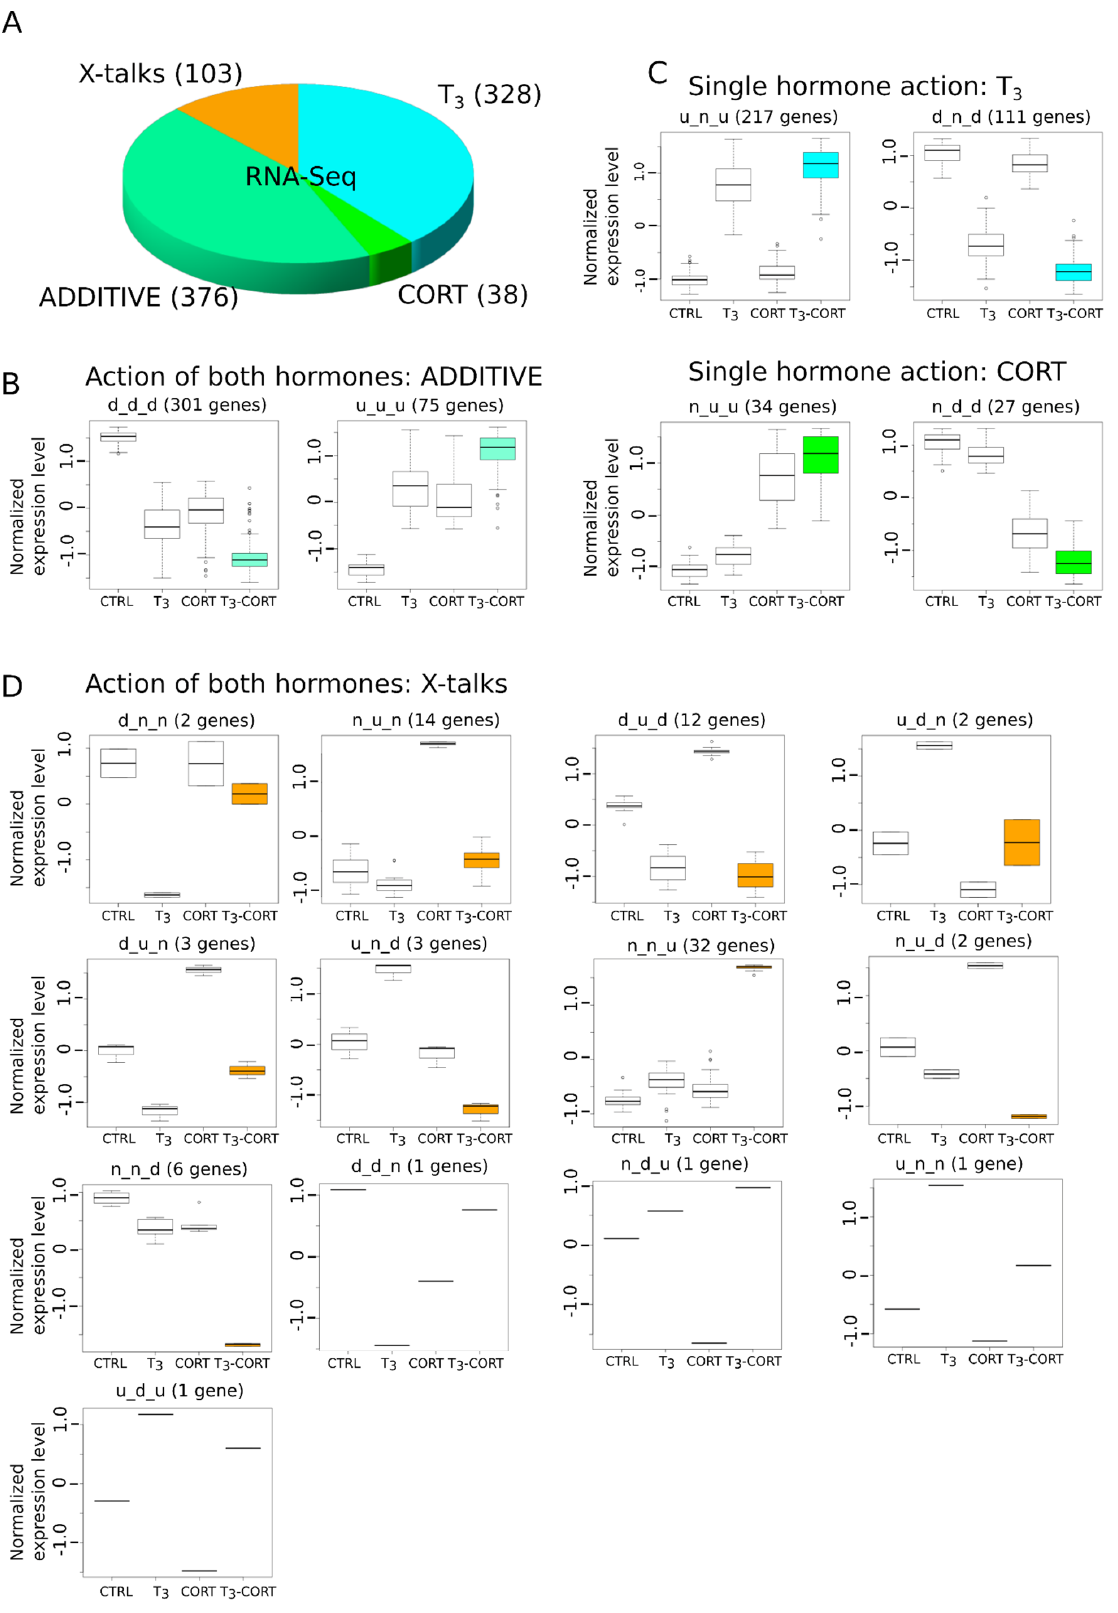
Figure 3. Gene expression is modulated by one, the other, or both hormones. Only genes displaying consistent expression between explants culture and whole animals were kept. ( A ) Types of gene regulation by T 3 and CORT. ( B ) Gene regulation by either T 3 or CORT. ( C ) Gene regulation by T 3 and CORT. ( D ) Complex regulation by both hormones